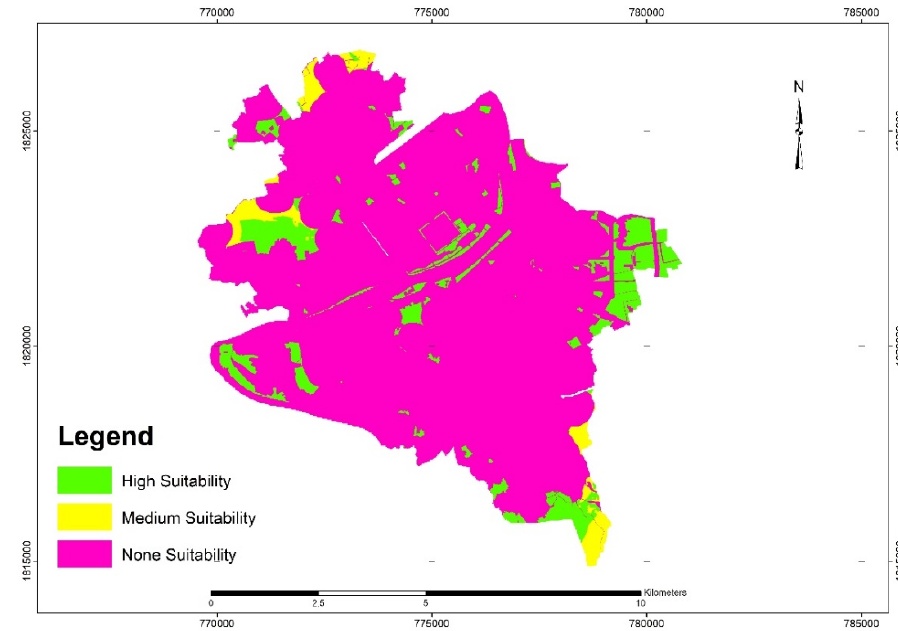
Figure 8. Suitability map for urban green spaces in Hue City ( sources: authors ).